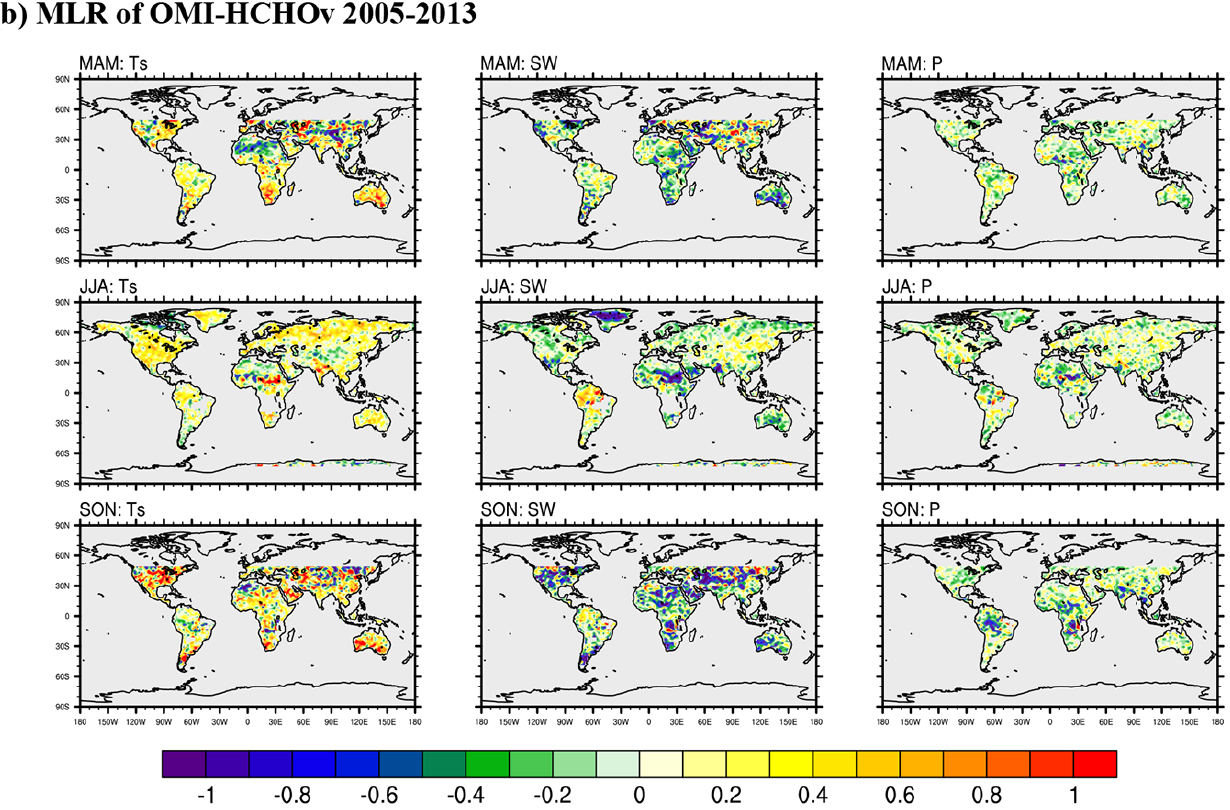
Figure 2. (a) The covariance of FLUXNET GPP with monthly mean T s , PAR and P in MAM (top), JJA (middle) and SON (bottom) from the MLR analysis. MLR is calculated using monthly mean data in 1982–2011. Significant regions ( p <0.05) are shown with dotted shading. (b) The covariance of OMI HCHOv with monthly mean T s , SW and P in MAM (top), JJA (middle) and SON (bottom) from the MLR analysis. MLR is calculated using monthly mean data in 2005–2013. Significant regions ( p <0.05) are shown with dotted